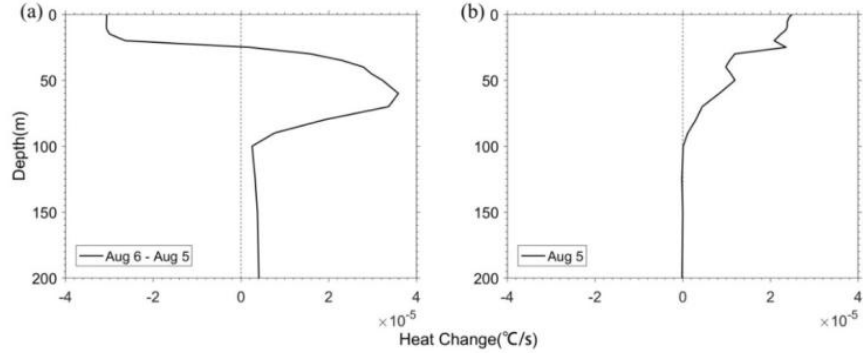
Figure 9. Vertical profiles of the terms ∂θ